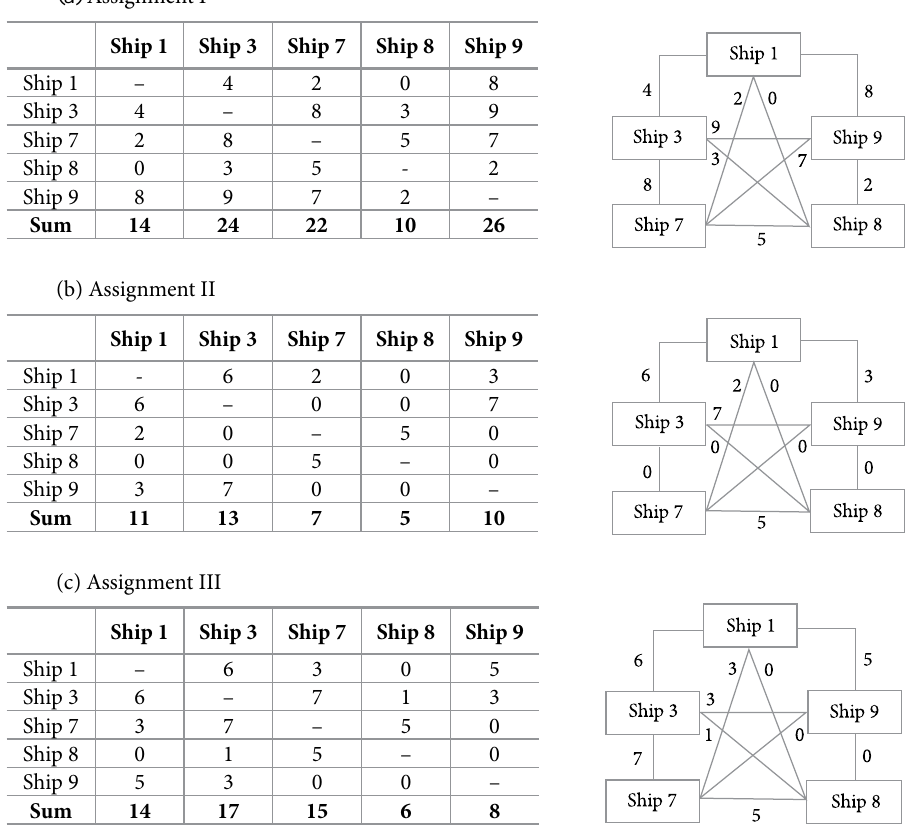
Fig. 3. Constraint matrices and corresponding constraint graphs for the assignments in Fig.